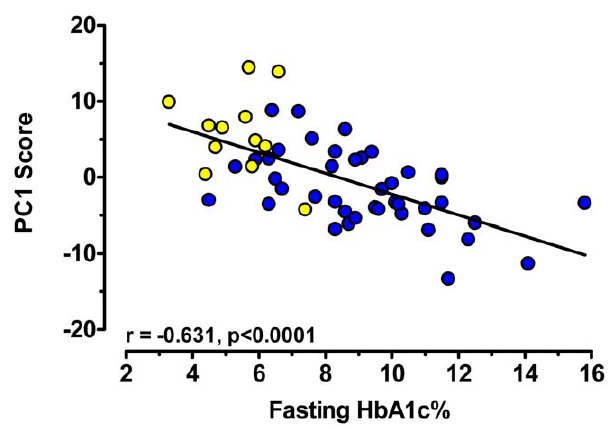
Figure 5. Correlation between PC1 scores and blood HbA1c% in non-diabetic (yellow circles) and type 2 diabetic (blue circles) obese women. PC1 scores derived from PCA analysis (see text and Figure 4 legend) were used for correlation to a marker of blood sugar control. Pearson’s r and p values for the correlation is given within the